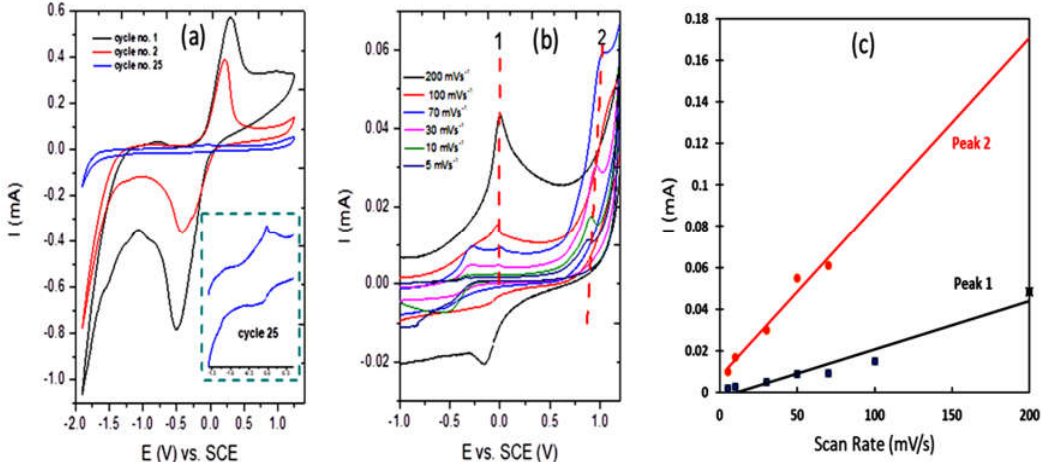
Figure 6. ( a ) Cyclic voltammograms of Cu-OC catalyst in 0.1 M KOH at scan rates of 200 mV/s, ( b ) cyclic voltammograms of Cu-OC catalyst in 0.1 M KOH at scan rates of 200, 100, 70, 30, 10 and 5 mV/s, and ( c ) anodic peak currents (Ia) as a function of the scan rate for the Cu-OC catalyst in 0.1 M KOH.